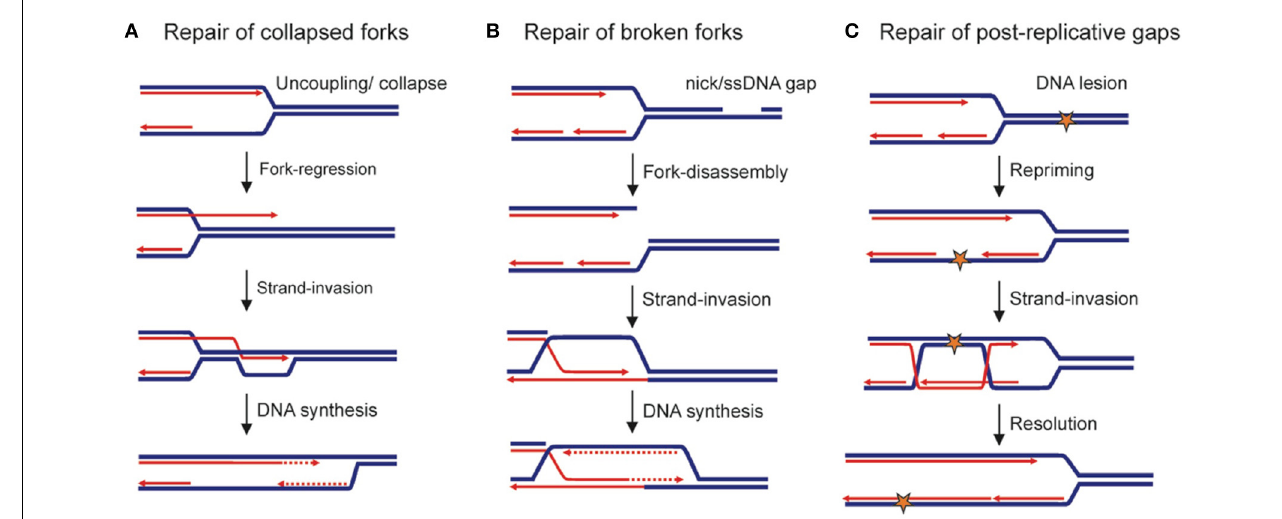
FIGURE 2 | Replication-maintenance by homologous recombination. Blue and red lines indicate parental and neo-synthesized strands, respectively. (A) Replication-restart following collapse of the replication